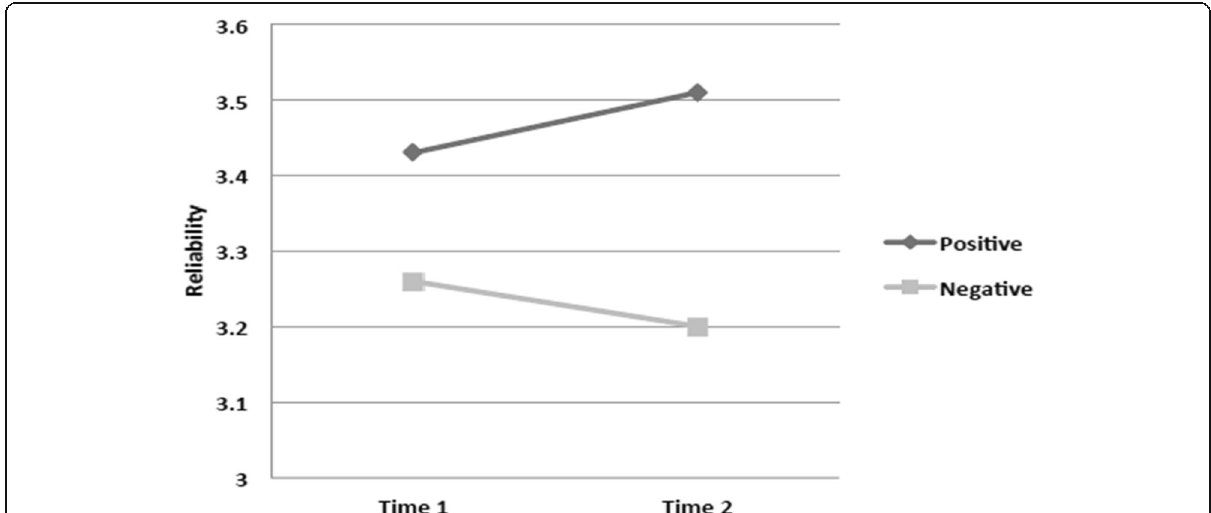
Fig. 3 Reliability means by condition at Time 1 and Time 2. The figure shows the difference in the mean perception of reliability between time 1